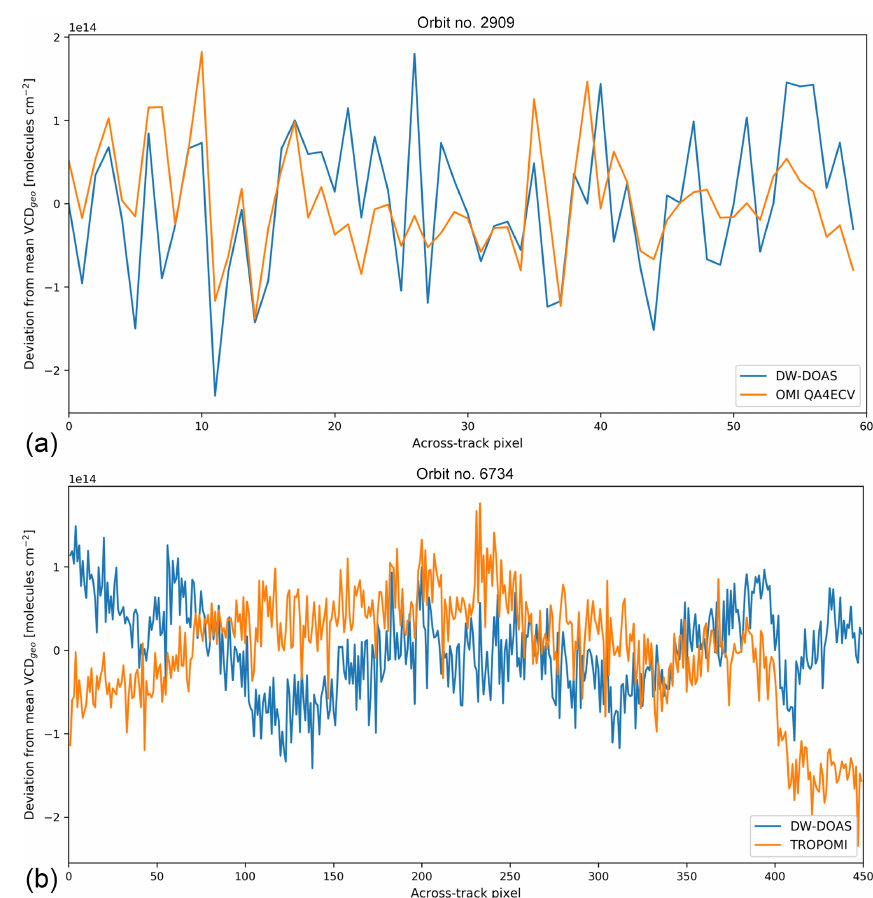
Figure 12. Striping sensitivity of DW-DOAS and the corresponding reference product for (a) OMI and (b) TROPOMI data for one orbit over the Pacific Ocean in the latitude range 30 ◦ S–5 ◦